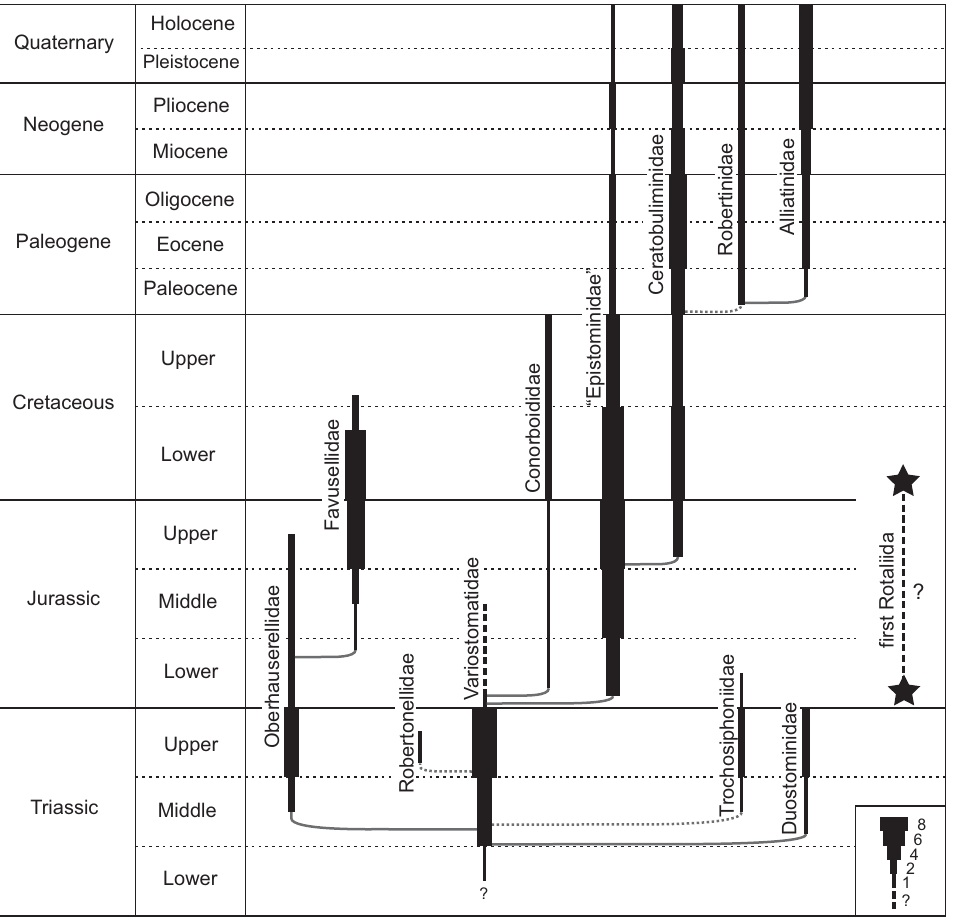
Fig. 6. Mesozoic–Recent phyletic tree of Robertinida, at the family level. Line width indicates the generic di- versity for the different families (see bottom-right for associated number of genera). “Epistominidae” include the sub families Epistomininae, Garantelli- nae, and Reinholdellinae. Dashed lines indicate uncertain stratigraphic distri- bution, dotted lines indicate uncertain phyletic